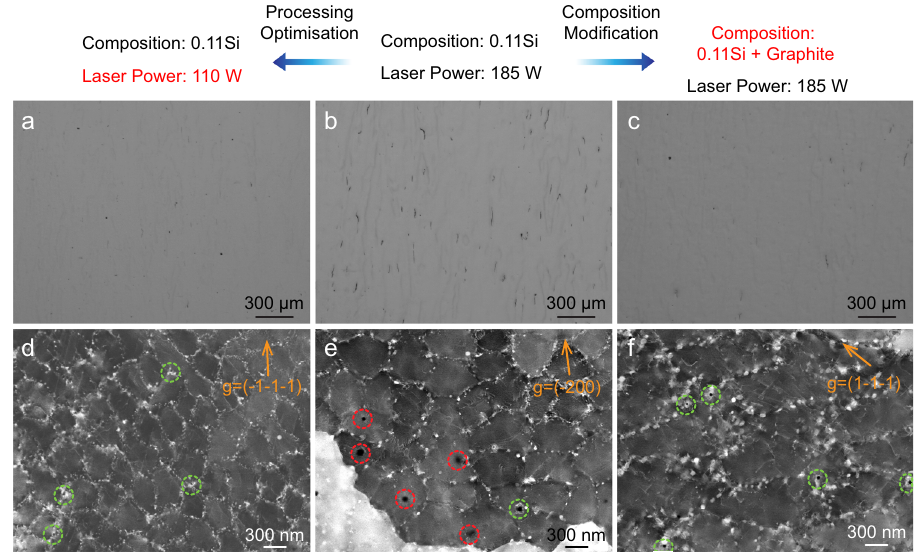
Fig. 8 | Hot crack minimization through both processing optimization and composition modi fi cationfor the 0.11Si alloy. a Optical image of the 0.11Si alloy builtwithalowerlaserpowerinputof110W. b Opticalimageofthe0.11Sialloybuilt withtheoriginallaserpowerinputof185W. c Opticalimageofthesamplebuiltwith